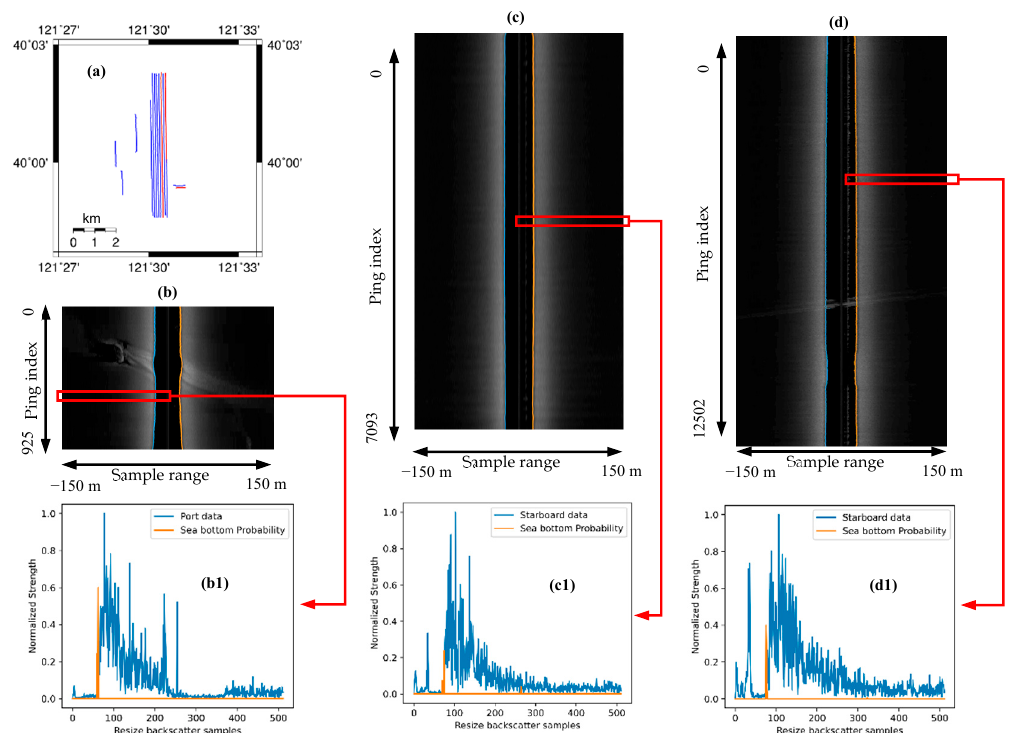
Figure 14 . Model validation using side-scan data in Bayuquan. ( a ) shows the survey track lines, and the red lines were selected for validation of the 1D-UNet model. ( b – d ) are the bottom detection and tracking results of these three selected survey lines. ( b1 ), ( c1 ) and ( d1 ) are the bottom detection result of three backscatter strength sequences from these three lines.